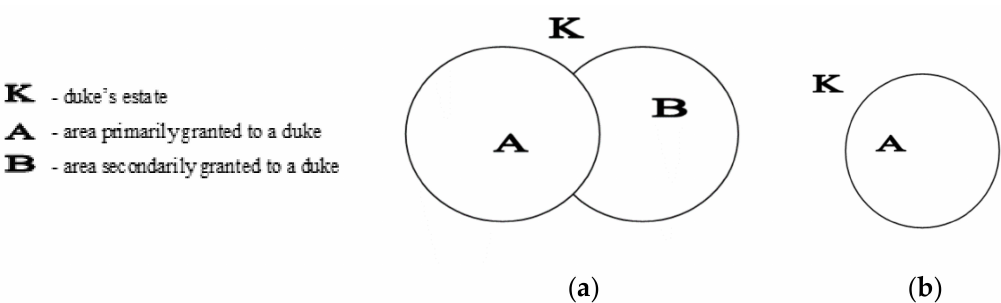
Figure 1. Models of demarcation lines formed with the ujazd technique. ( a ) Model of the primary demarcation ( b ) Model of the secondary demarcation. Source: based on